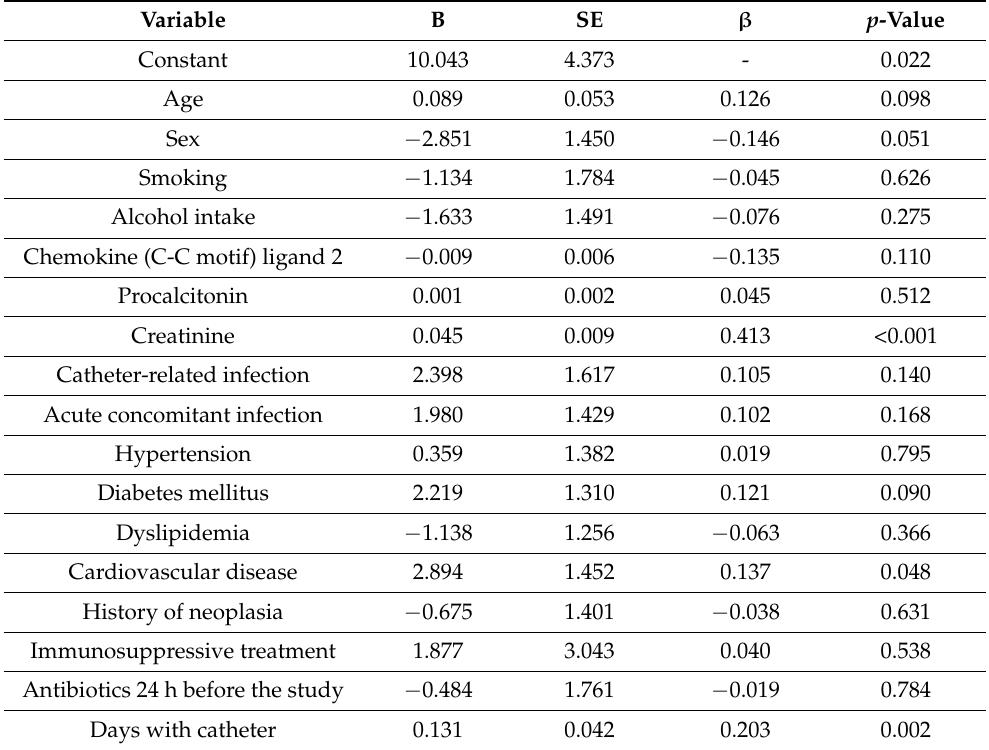
Table 5. Multiple regression analysis of the combined influence of clinical characteristics and biochem- ical variables on plasma galectin-3 concentrations in patients with an indwelling urinary catheter. Model summary: r = 0.674; p <